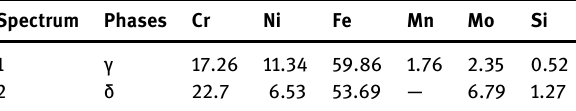
Table 4: EDS analysis obtained from Figure 7 ( wt% )